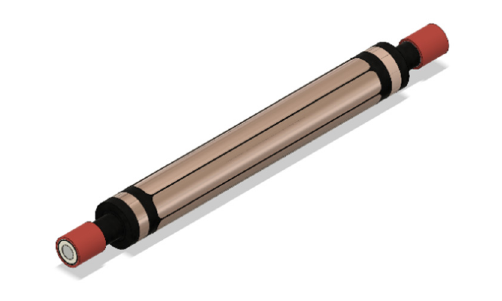
Figure 1. 3D render of the PD sensor.